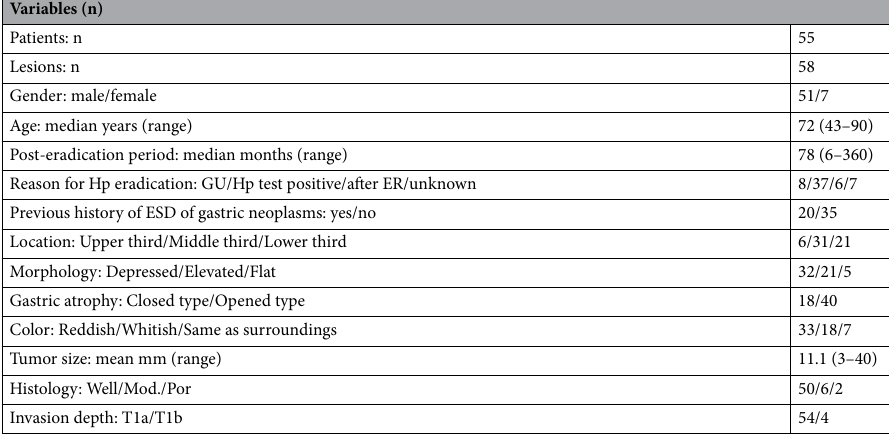
Table 1. Clinicopathological characteristics of patients and gastric neoplasms. GU gastric ulcer, Well well differentiated adenocarcinoma, Mod moderately differentiated adenocarcinoma, Por. poorly differentiated